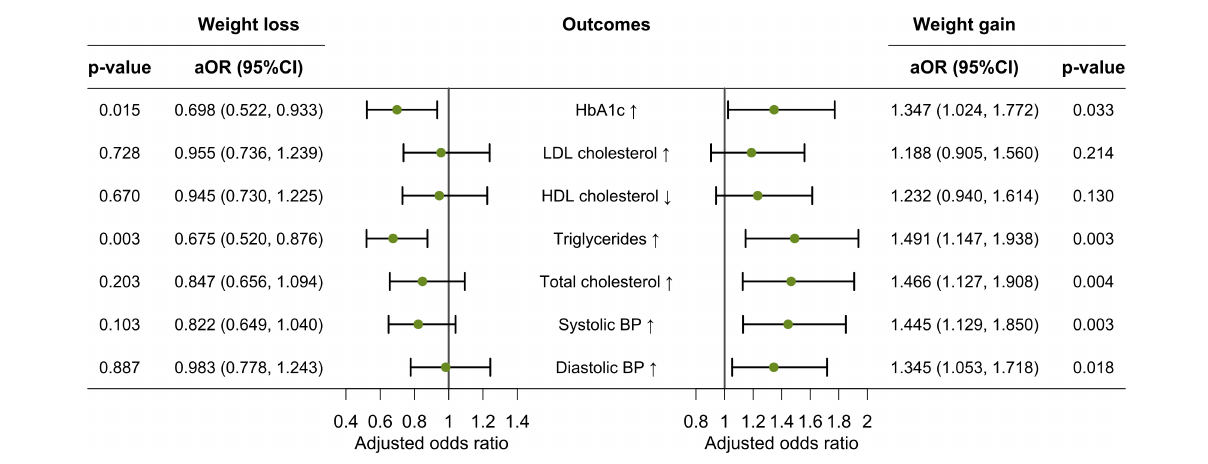
FIGURE 2 Multivariable logistic regression analysis of associations between weight loss/gain and worsening of CV risk factors. Note: aOR, adjusted odds ratio; HbA1c, haemoglobin A1c; LDL, low-density lipoprotein; HDL, high-density lipoprotein; BP, blood pressure. Weight gain was de fi ned as an increase of ≥ 3% in body weight, and weight loss was de fi ned as a decrease of ≥ 3% in body weight during the study period. Error bars indicate 95% con fi dence